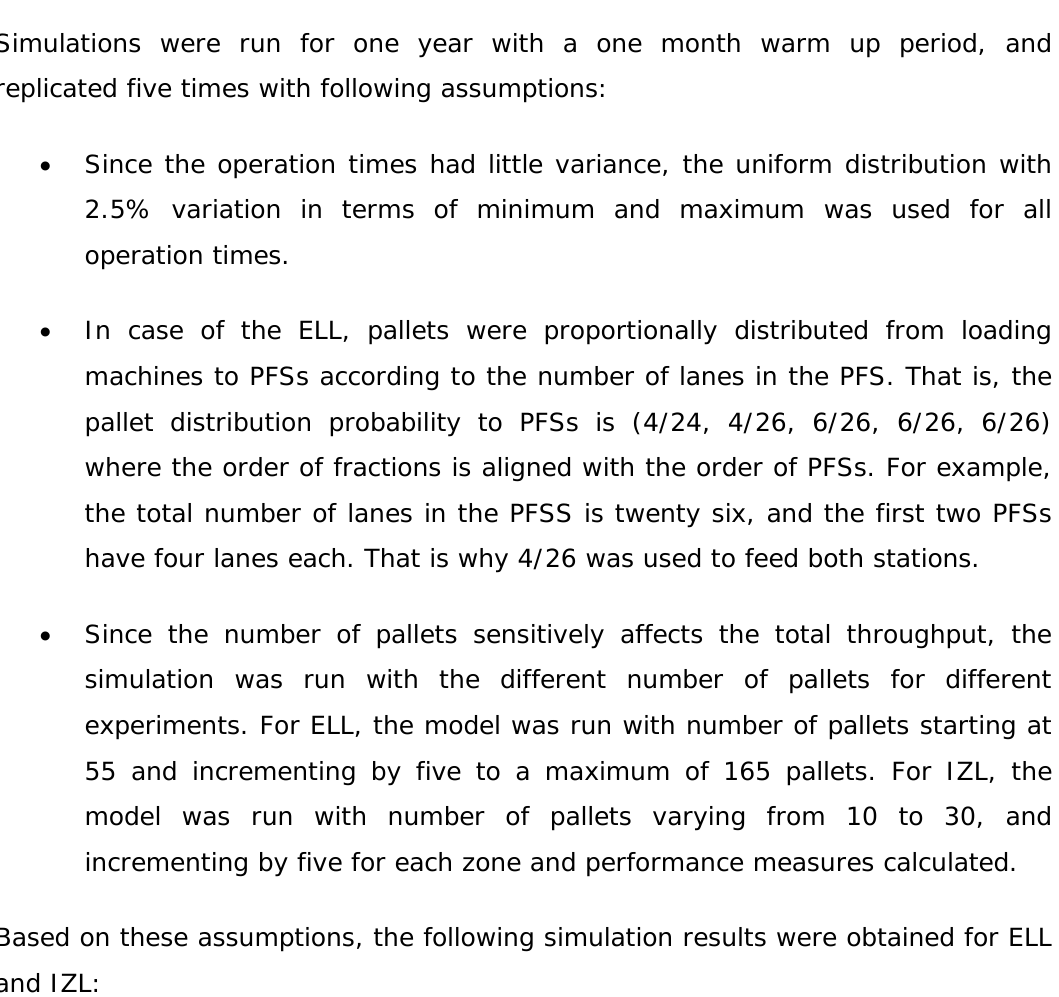
Table 4. “Processing time information”. Source: